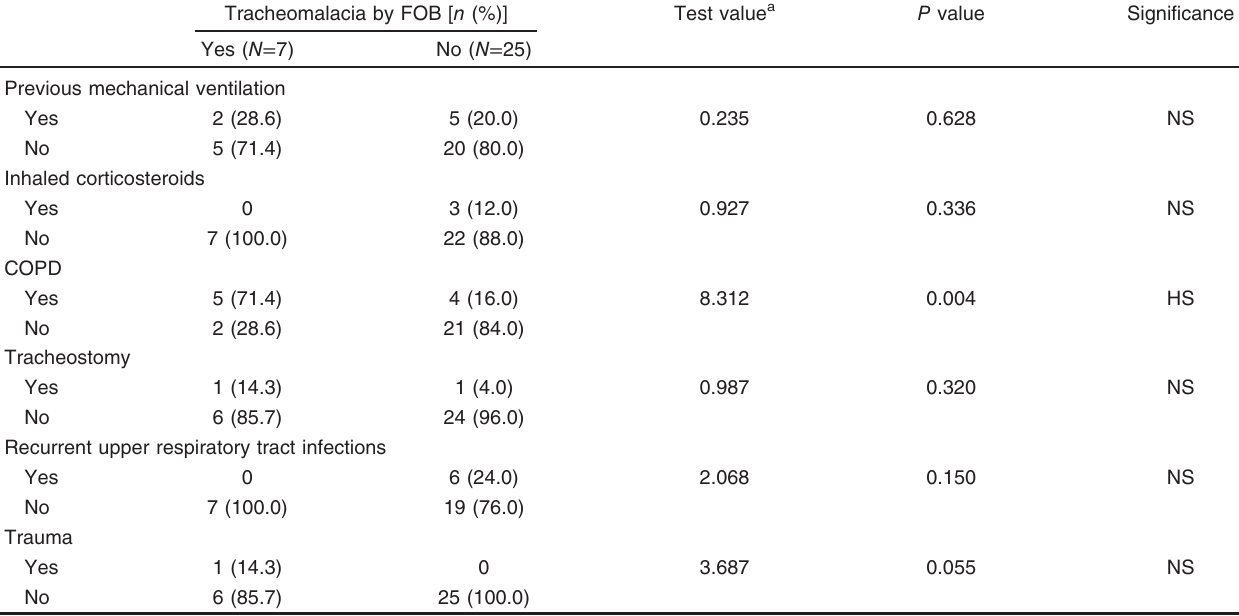
Table 9 Comparison between the findings of tracheomalacia by fiberoptic bronchoscopy in terms of the risk factors for tracheomalacia Tracheomalacia by FOB [ n (%)]